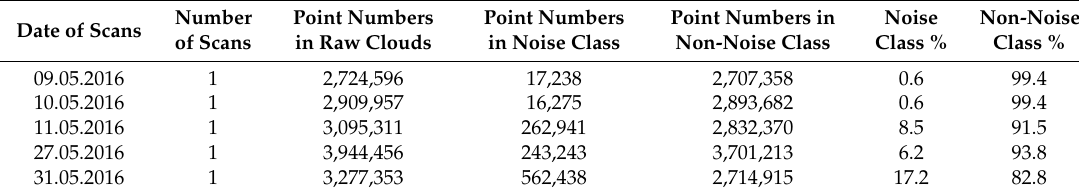
Figure 4. TLS-based orthophotos (black pixels represent no data). Table 2. TLS scan